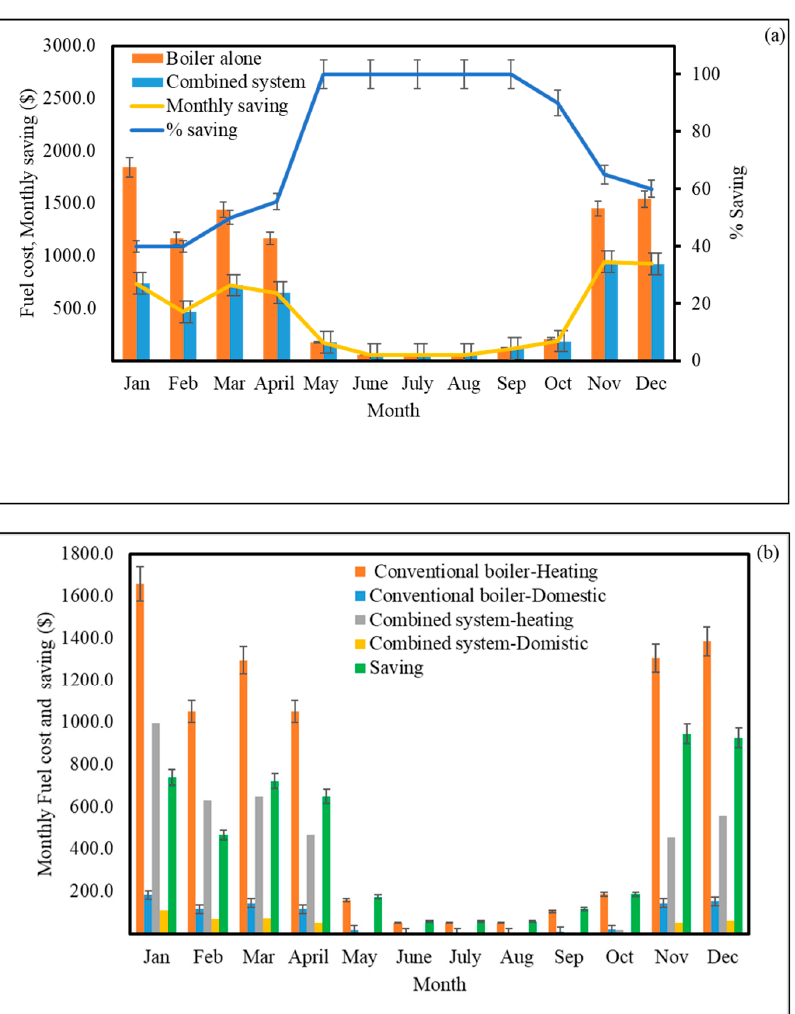
Figure 3. Energy cost analysis ( a ) The cost of heating using boiler alone and combined boiler–solar water heater, and ( b ) Monthly fuel cost of domestic hot water and space heating using boiler alone and combined boiler–solar water heater.